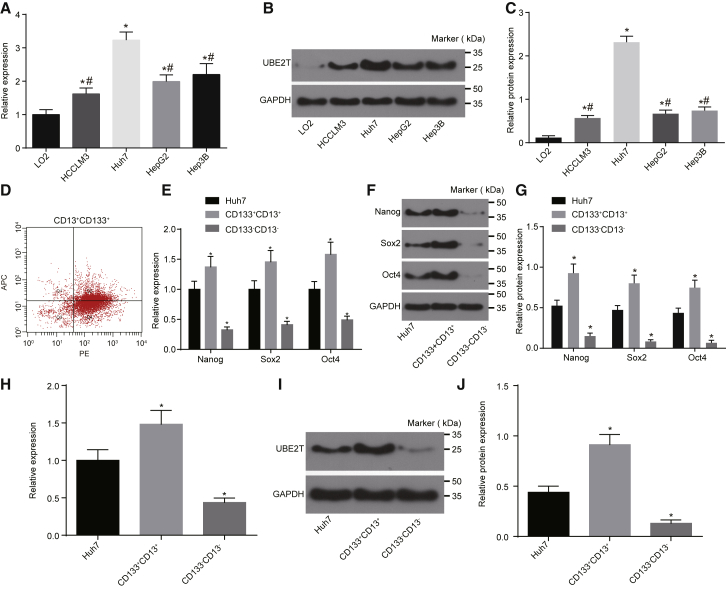
UBE2T Was Highly Expressed in LCSCs(A) The mRNA expression of UBE2T in the HCC cell line and normal hepatic epithelial cell line determined by qRT-PCR. (B) The gray value of the UBE2T protein band in the HCC cell line and normal hepatic epithelial cell line. (C) The protein expression of UBE2T in the HCC cell line and normal hepatic epithelial cell line, determined by western blot analysis. (D) LCSCs sorted in the Huh7 cells by flow cytometry. (E) The mRNA expression of Nanog, Sox2, and Oct4 in Huh7 cells, CD13+CD133+ cells, and CD13−CD133− cells, measured by qRT-PCR. (F) The gray value of Nanog, Sox2, and Oct4 protein bands in Huh7 cells, CD13+CD133+ cells, and CD13−CD133− cells measured by western blot analysis. (G) The protein expression of Nanog, Sox2, and Oct4 in Huh7 cells, CD13+CD133+ cells, and CD13−CD133− cells, measured by western blot analysis. (H) The mRNA expression of UBE2T in Huh7 cells, CD13+CD133+ cells, and CD13−CD133− cells, determined by qRT-PCR. (I) The gray value of UBE2T protein band in Huh7 cells, CD13+CD133+ cells and CD13−CD133− cells determined by western blot analysis. (J) The protein expression of UBE2T in Huh7 cells, CD13+CD133+ cells, and CD13−CD133− cells, determined by western blot analysis. *p < 0.05 versus the LO2 cells; #p < 0.05 versus the Huh7 cells. Statistical data were described as mean ± SD and was compared using one-way ANOVA. The experiment was repeated 3 times, independently.